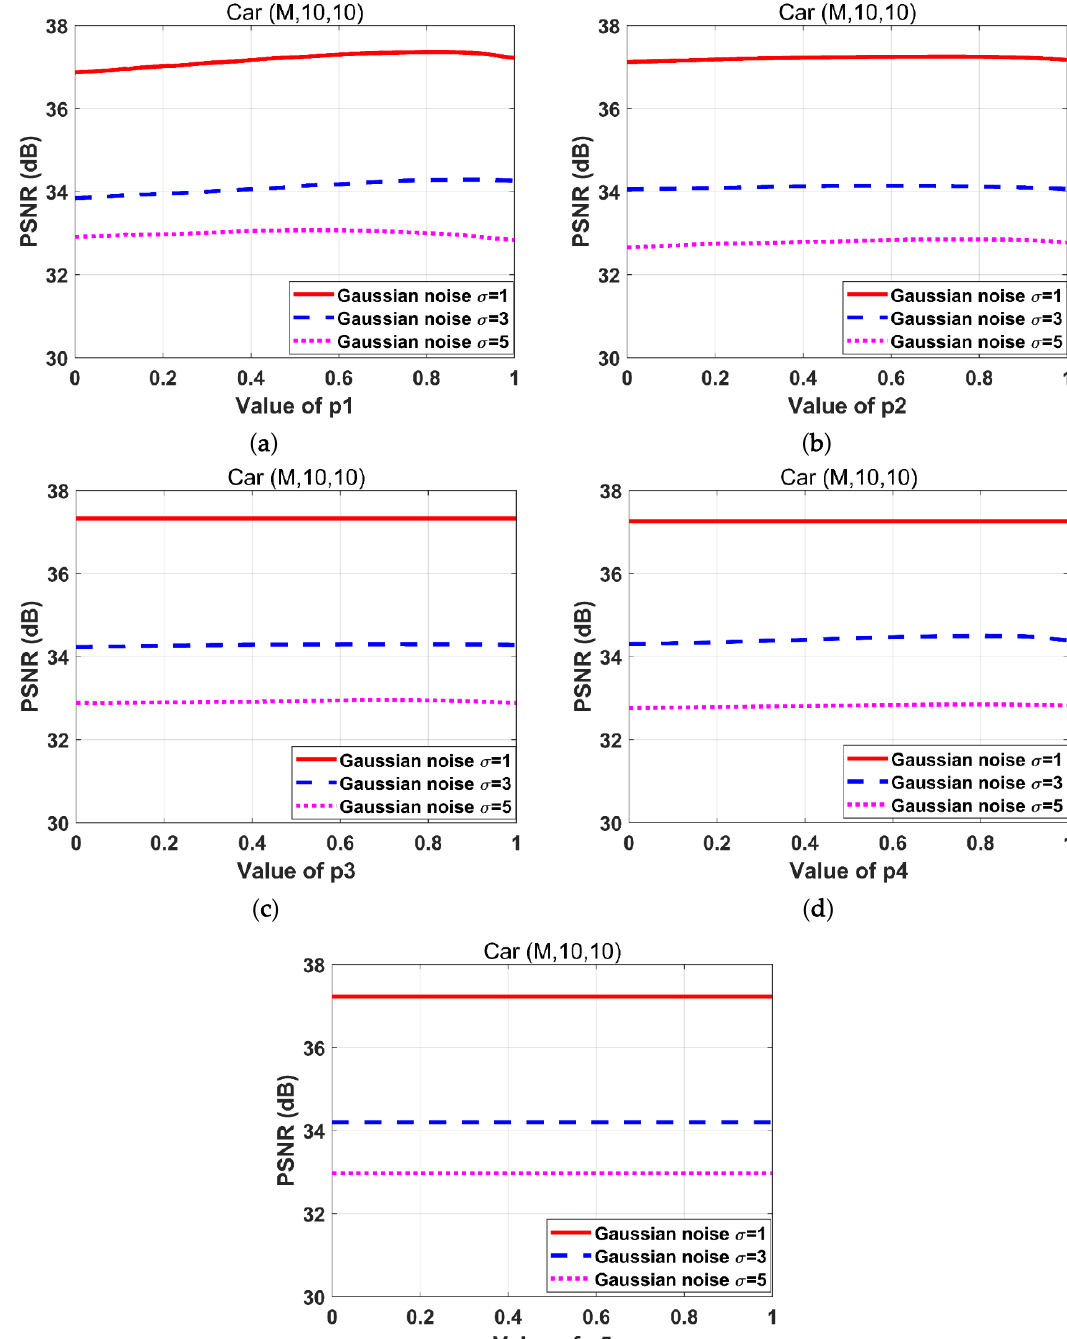
Figure 4. Effects of variations on the PSNR for the “Car” images degraded by the motion blur kernel (M, 10, 10) with Gaussian noise standard deviations 1, 3, and 5 respectively. ( a ) p 1 ; ( b ) p 2 ; ( c ) p 3 ; ( d ) p 4 ; ( e ) p 5